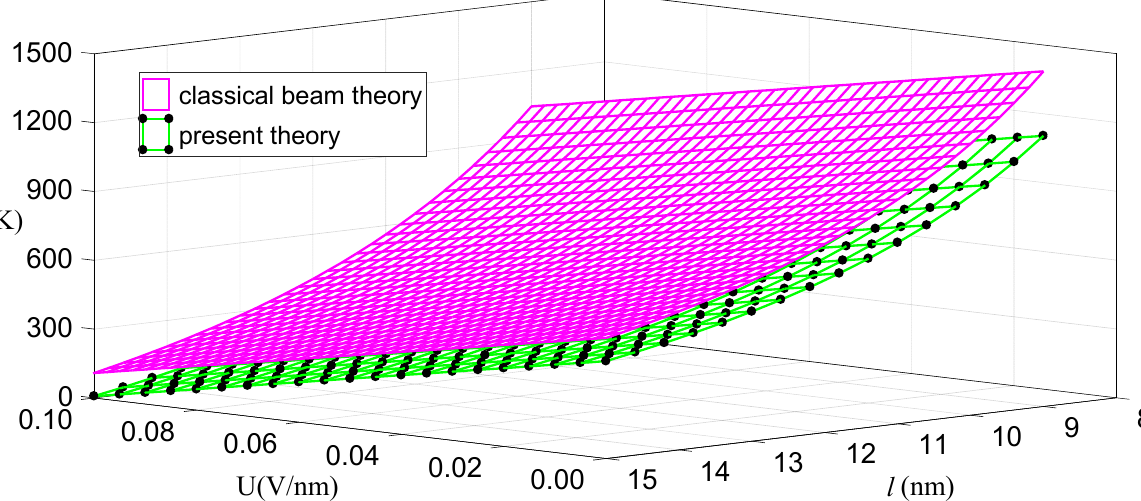
Figure 3. Critical temperature as a function of critical electric field intensity and critical length.